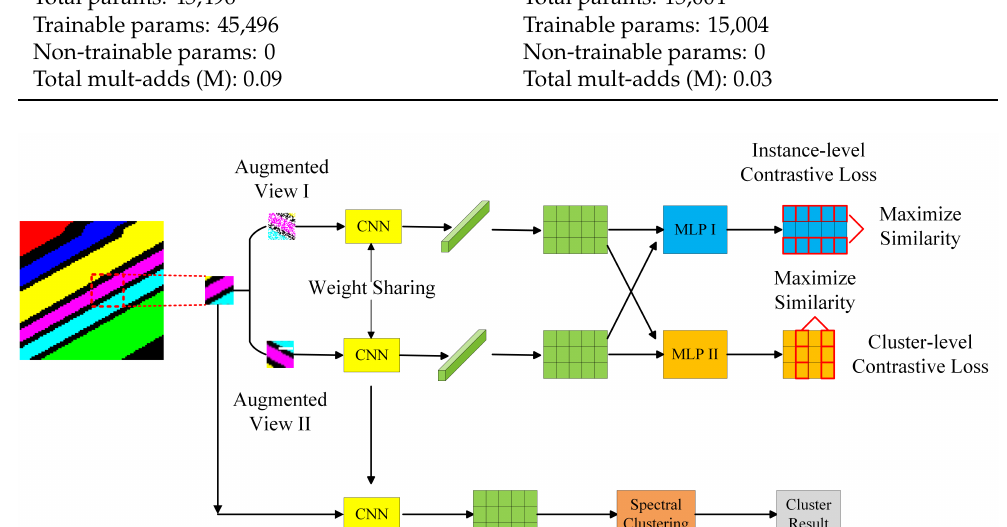
Figure 2. The overall architecture of our proposed method.